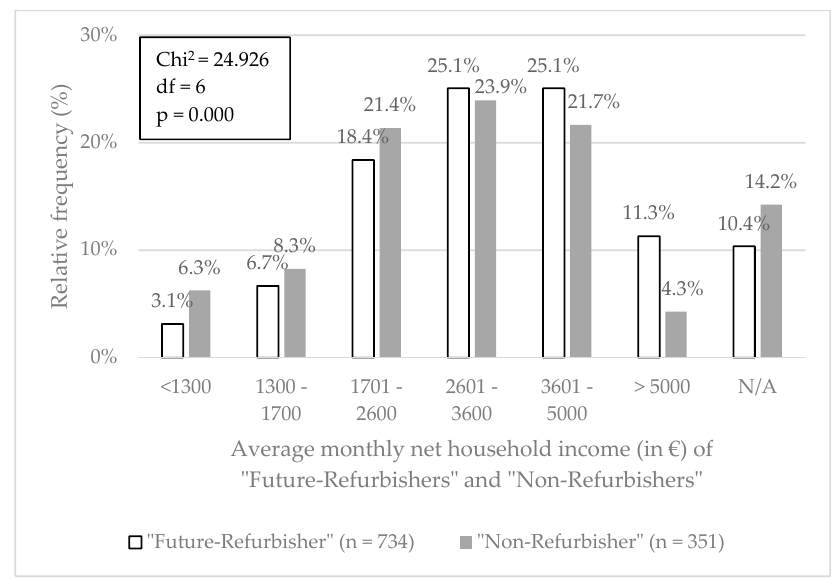
Figure 3. Average monthly net household income (in €) for “Future-Refurbishers” and “Non- Figure 3. Averagemonthlynethouseholdincome(in € )for“Future-Refurbishers”and“Non-Refurbishers”. Energies 2019 , 12 , x FOR PEER REVIEW Refurbishers”.